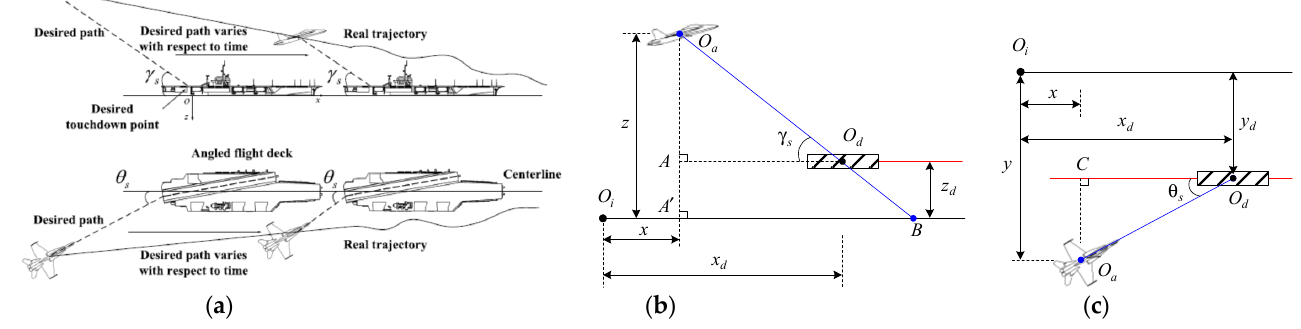
Figure 3. Aircraft-ship relative motion in longitudinal- and lateral-directional planes ( a ), in longitudinal-directional plane ( b ), in lateral-directional plane ( c